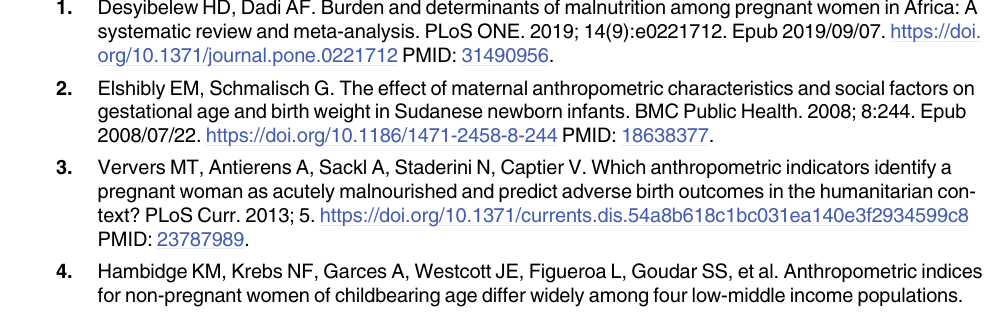
S14 Table. Infant birth outcomes by maternal vaginal dysbiosis status among the interven- tion group. S15 Table. Trials giving azithromycin in pregnancy with > 1,200 participants in low- and middle-income